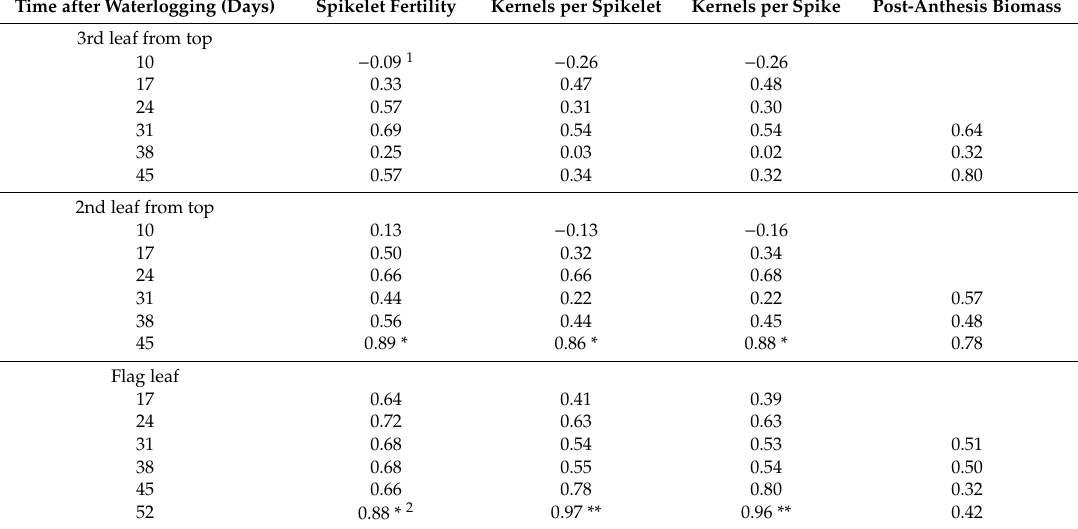
Table 4. Correlation coe ffi cients of spikelet fertility, kernels per spikelet, kernels per spike, and post- anthesis biomass with chlorophyll content of the top three